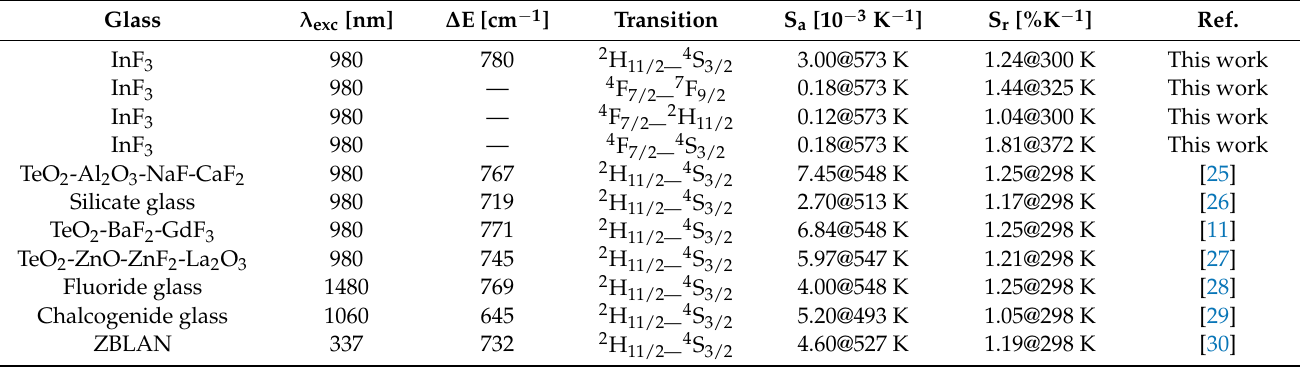
Table 1. Optical thermometric parameters of fluoroindate glass and other glasses.